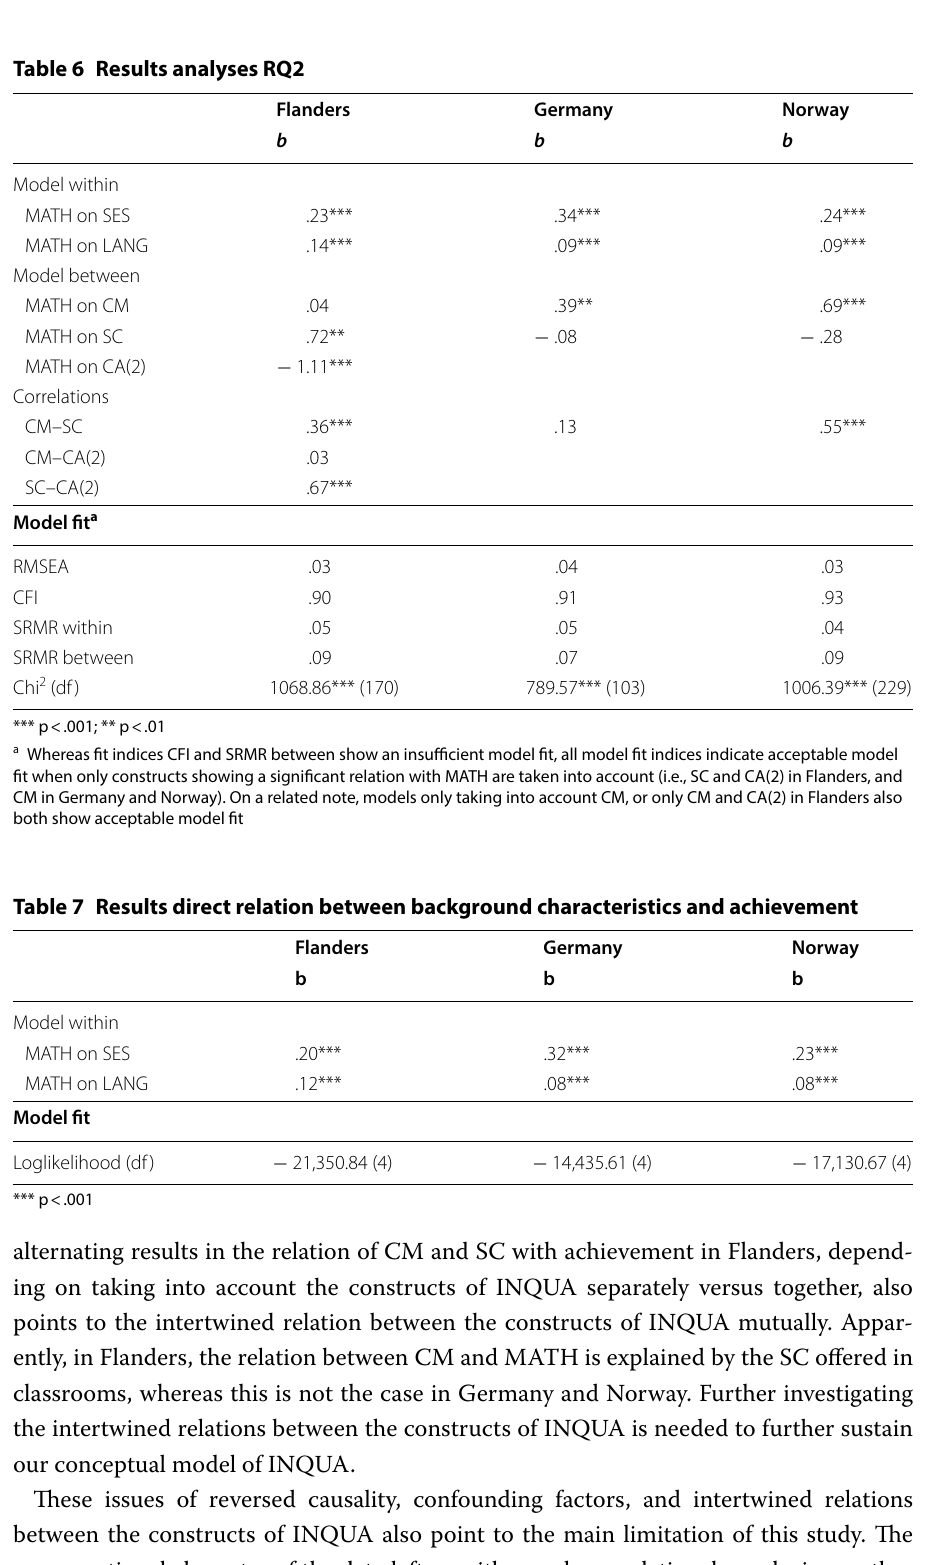
Table 6 Results analyses RQ2